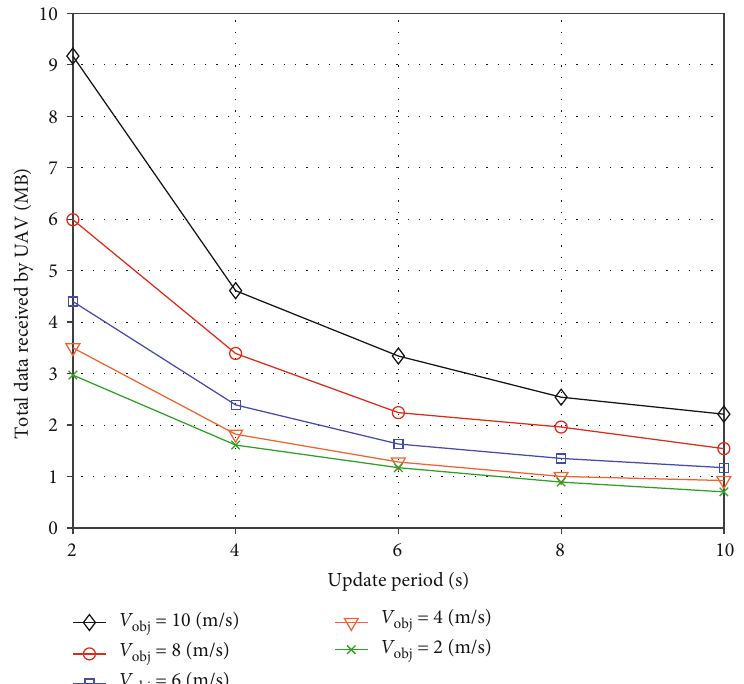
Figure 11: Data load exchanged between UAV and sensors. The volume strongly depends on velocity of the target object, especially when data update interval is short.